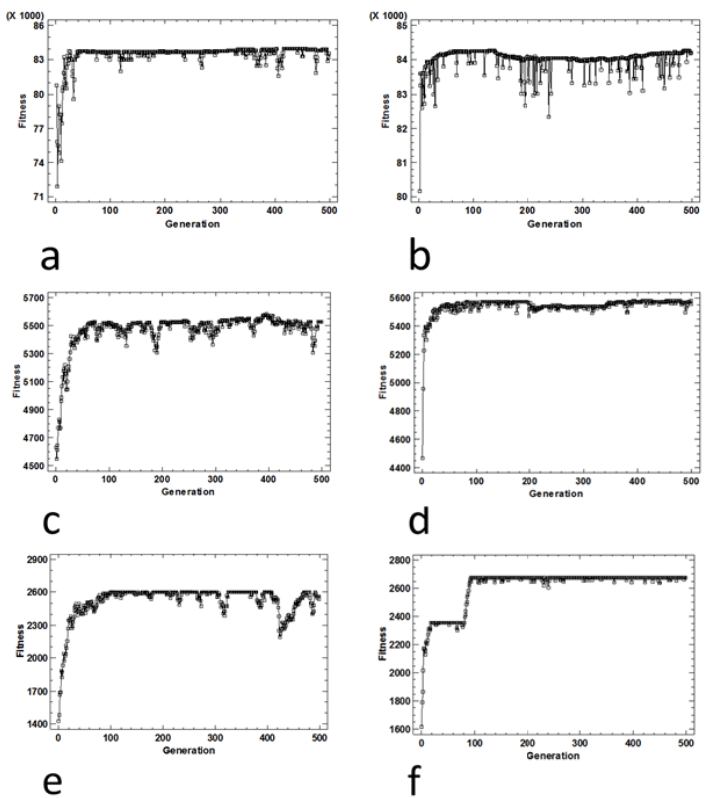
Figure 11. Performance graph (average fitness per generation) for the 2-SAT problem obtained under ( a ) SGA with antibiotic screening procedure, ( b ) SMGA with antibiotic screening procedure, ( c ) SGA with Lac operon screening procedure, ( d ) SMGA with Lac operon screening procedure, ( e ) SGA with chemotaxis screening procedure and ( f ) SMGA with chemotaxis screening procedure.